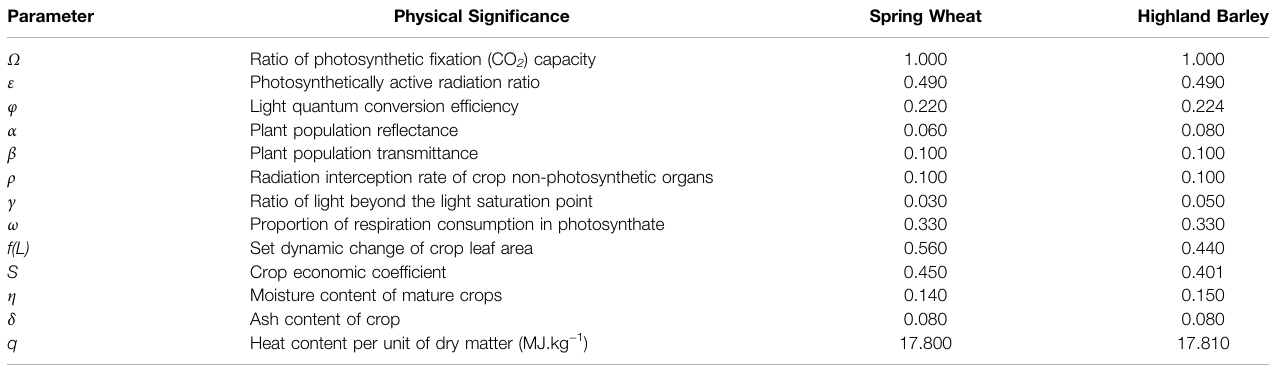
TABLE 1 | Photosynthetic production potential parameters of crops.